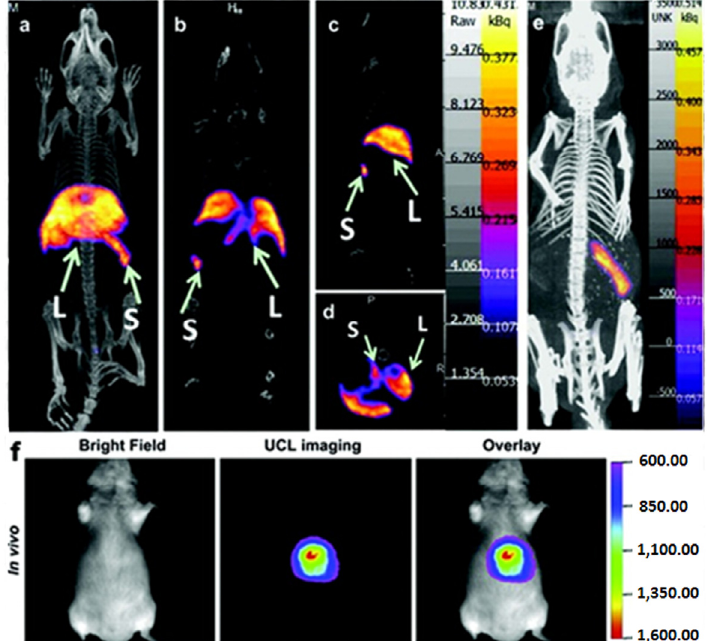
Figure 10. In vivo Single Photon Emission Tomography (SPECT)/Optical imaging study after intravenous injection of 153 Sm-UCNPs. ( a ) Whole-body three-dimensional projection, ( b ) coronal, ( c ) sagittal and ( d ) transversal images acquired at 1 h and ( e ) whole-body three-dimensional projection images acquired at 24 h are shown respectively. The arrows in the inset point to the liver (L) and spleen (S). ( f ) In vivo upconversion luminescence imaging of the Kunming mouse 1 h after tail vein injection of the 153 Sm-UCNPs (20 mg/kg). Adapted with permission from reference [105]. Copyright: Elsevier,